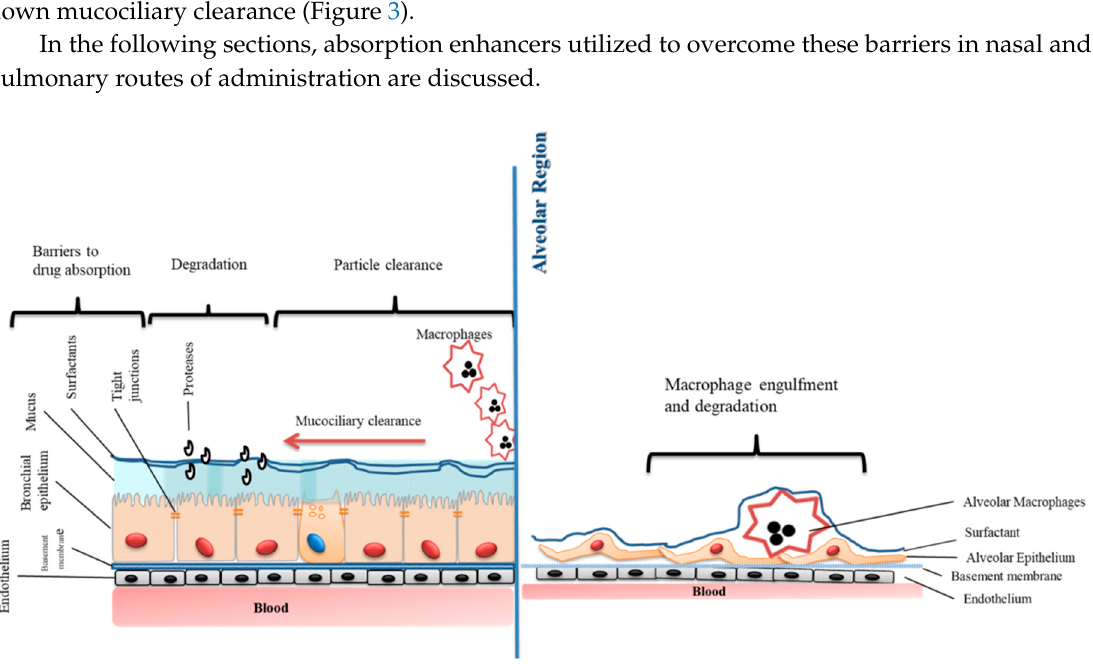
Figure 3. Hurdles for the absorption of drugs via inhalation .